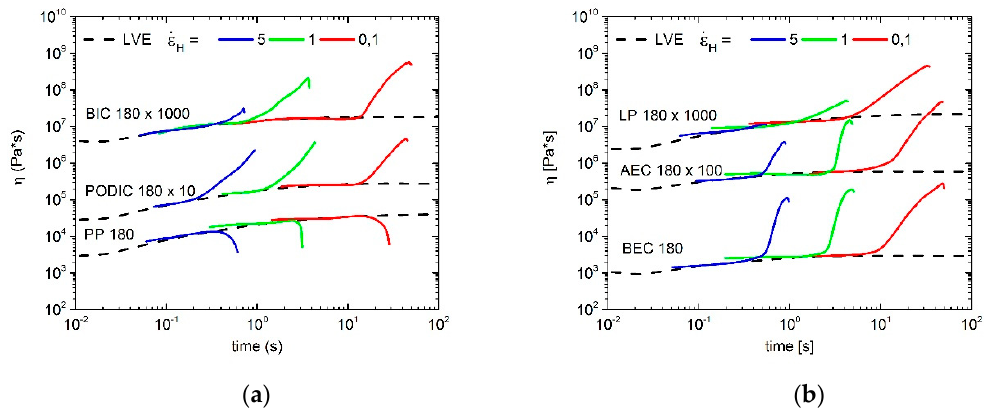
Figure 8. Extensional rheology of the different PP samples, (a) unmodified PP, PODIC and BIC; (b) BEC, AEC and LP, extruded at 180 °C; measured at 180 °C.